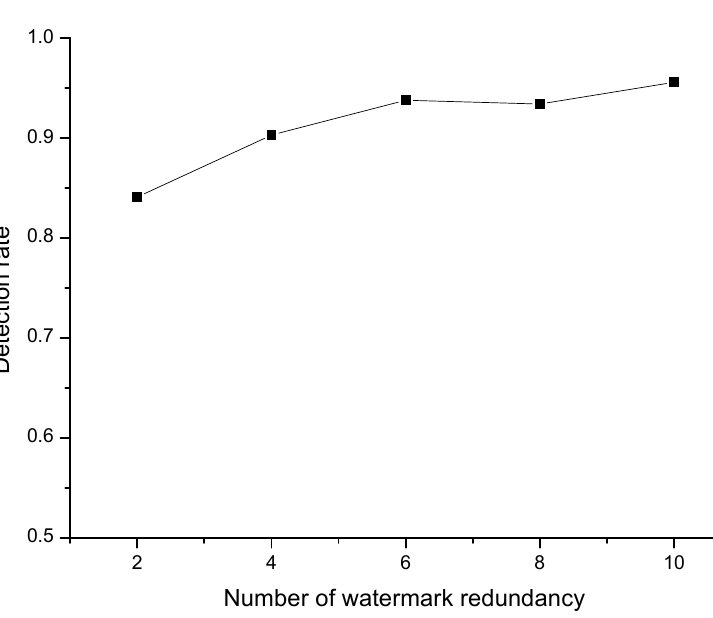
Figure 10. Effect of watermarking redundancy times.